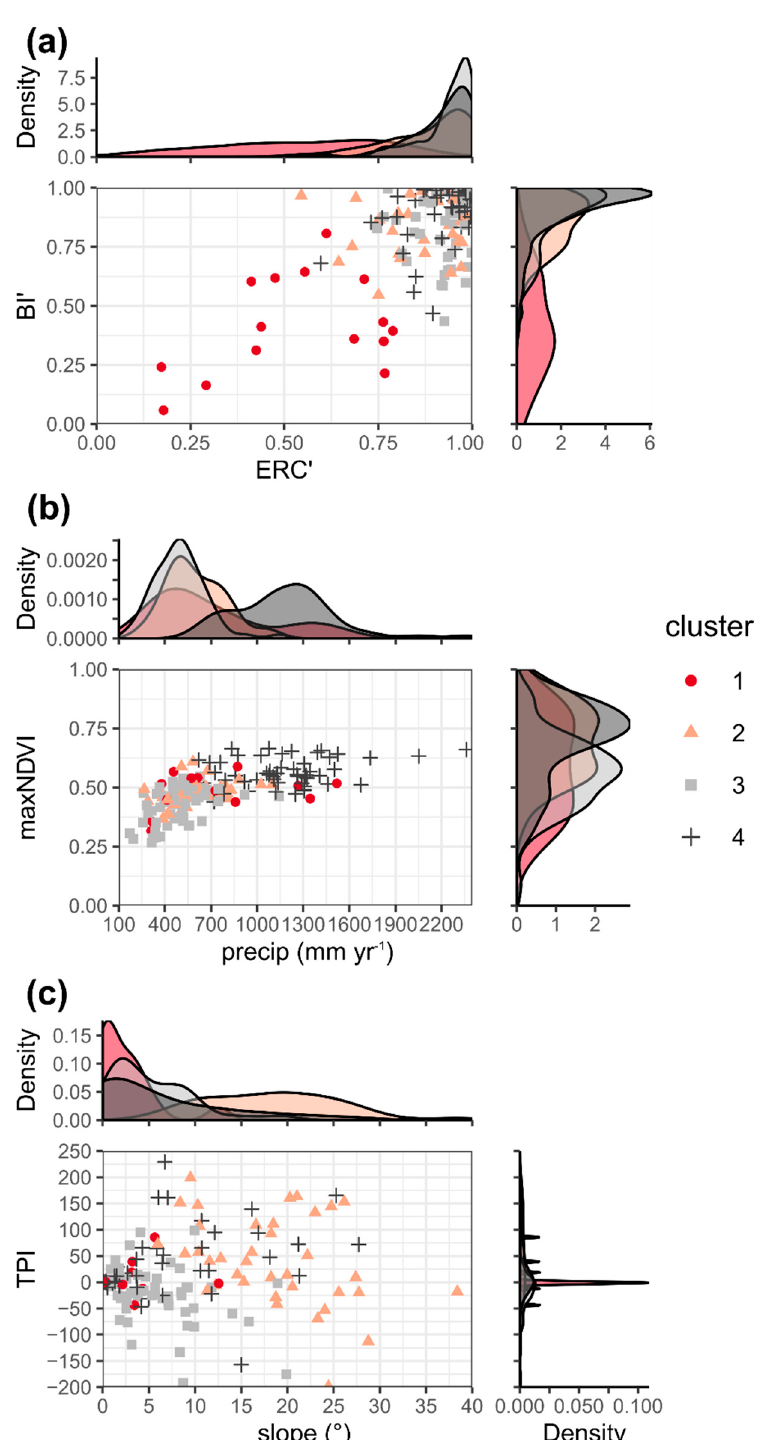
Figure 5. Scatter plots of environmental variables at the time and location of 166 firefighter entrapments (1981–2017). Plots representing the corresponding kernel densities by cluster are also shown for each axis. The variables are grouped by fire environment type: ( a ) fire danger, which includes BI’ and ERC’; ( b ) fuel related variables, including maxNDVI and precip; and ( c ) topography related variables, including TPI and slope steepness. See Table 2 for variable definitions.